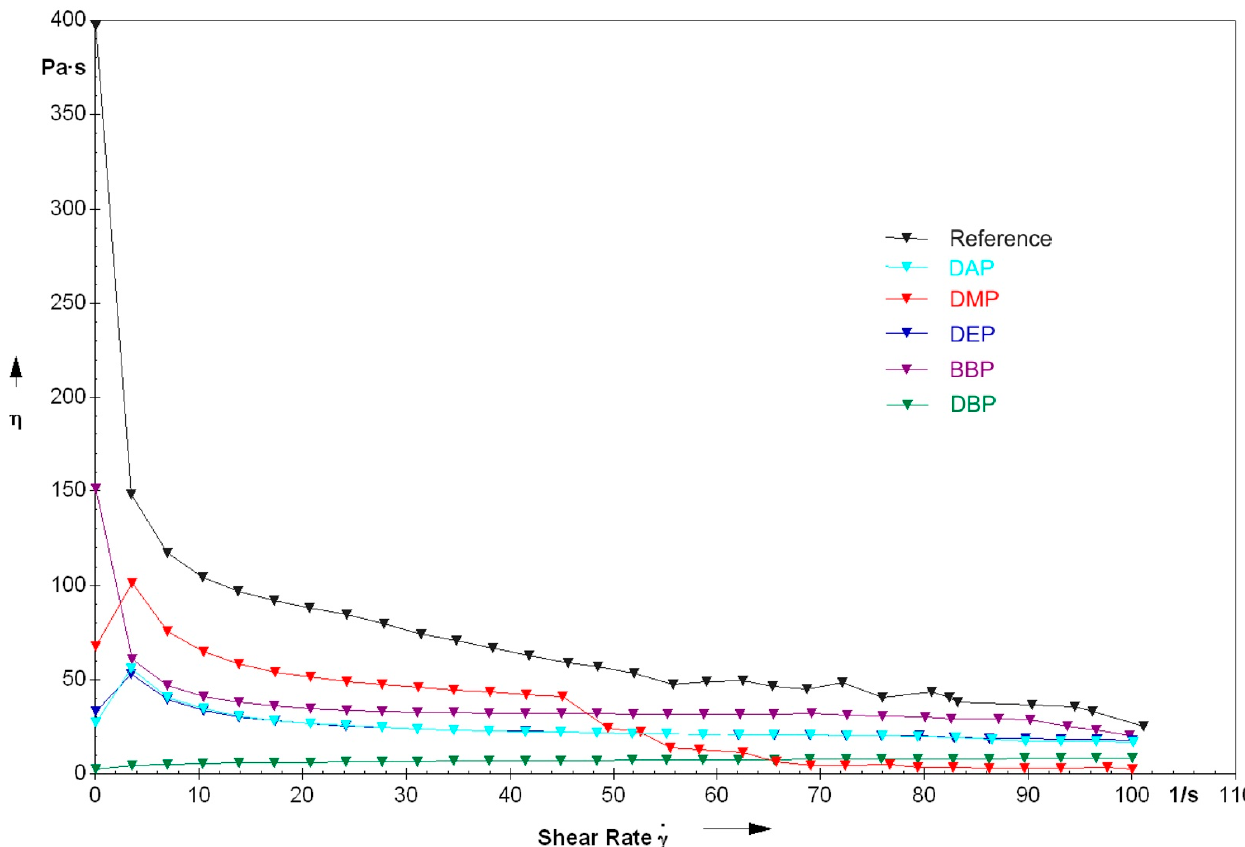
Figure 10. Viscosity in relation to shear rate for lithium disilicate suspensions prepared by using various phthalates .